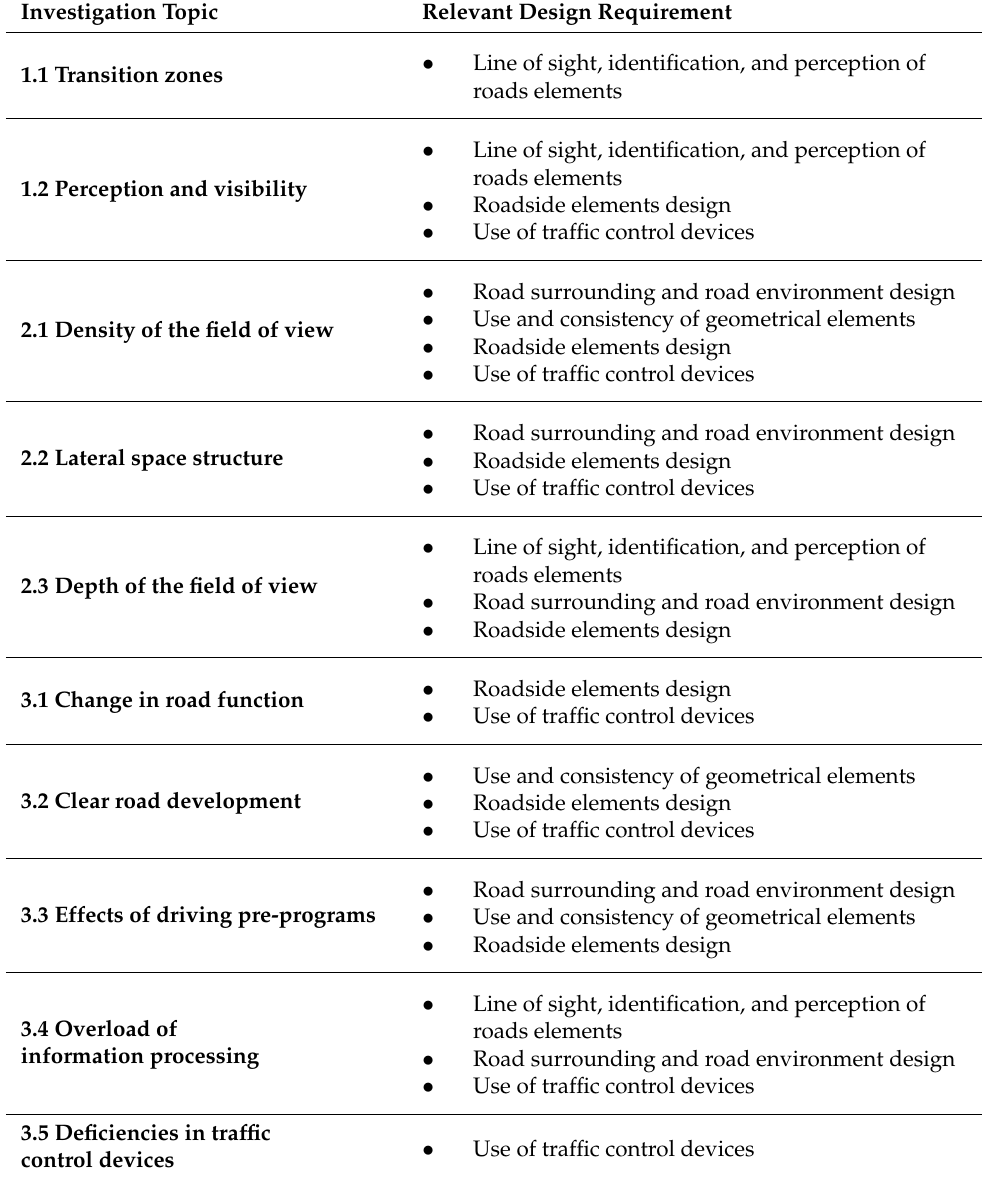
Table 4. Investigation topics and their related Relevant Design